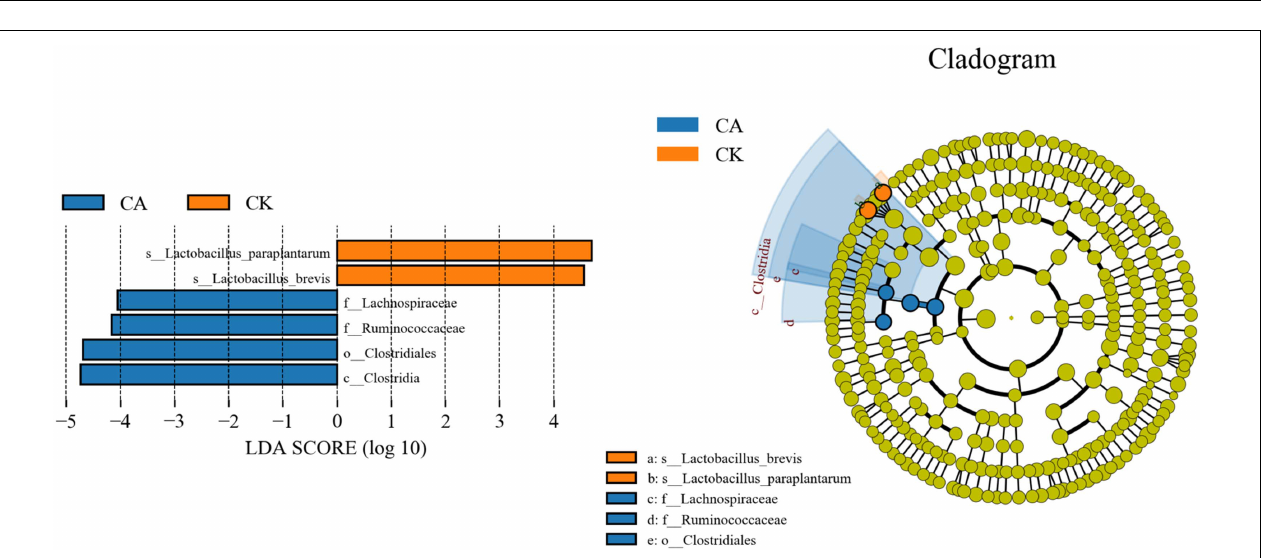
FIGURE 3 | The bacterial community and abundance at the phylum (A) and genus (B) levels in KG silage (CK, control; L, Lactobacillus plantarum ; CA, Citric acid; CAL, Citric acid + Lactobacillus plantarum ).